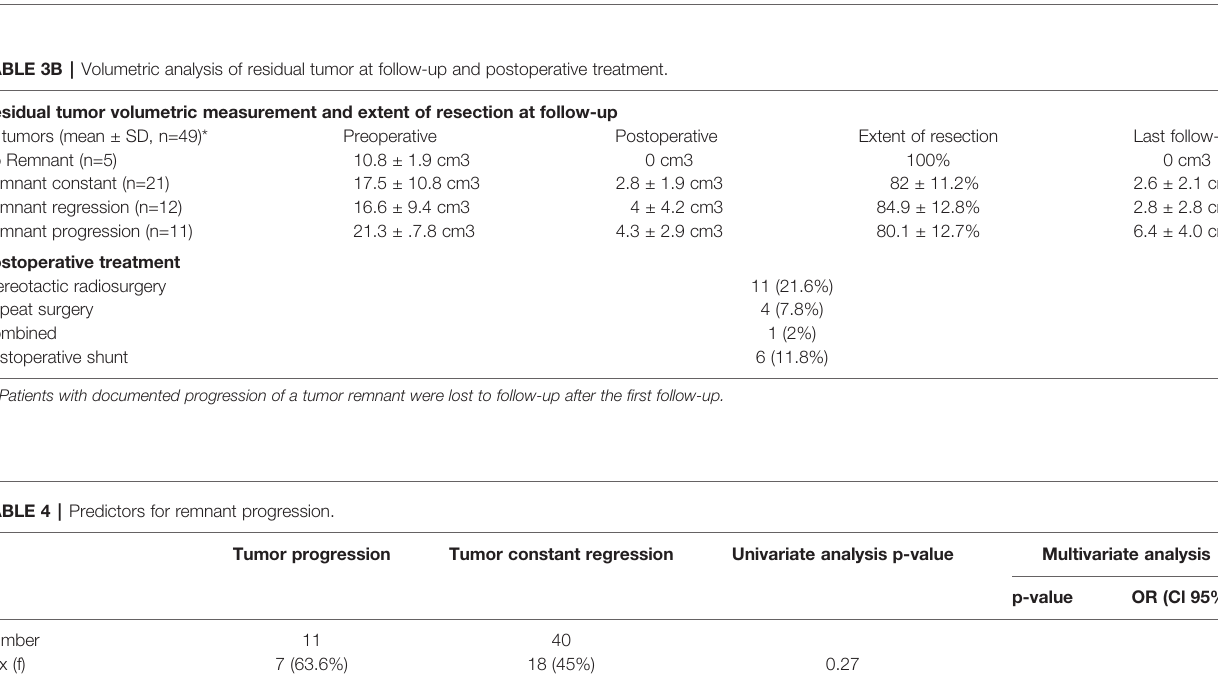
TABLE 3B | Volumetric analysis of residual tumor at follow-up and postoperative treatment.